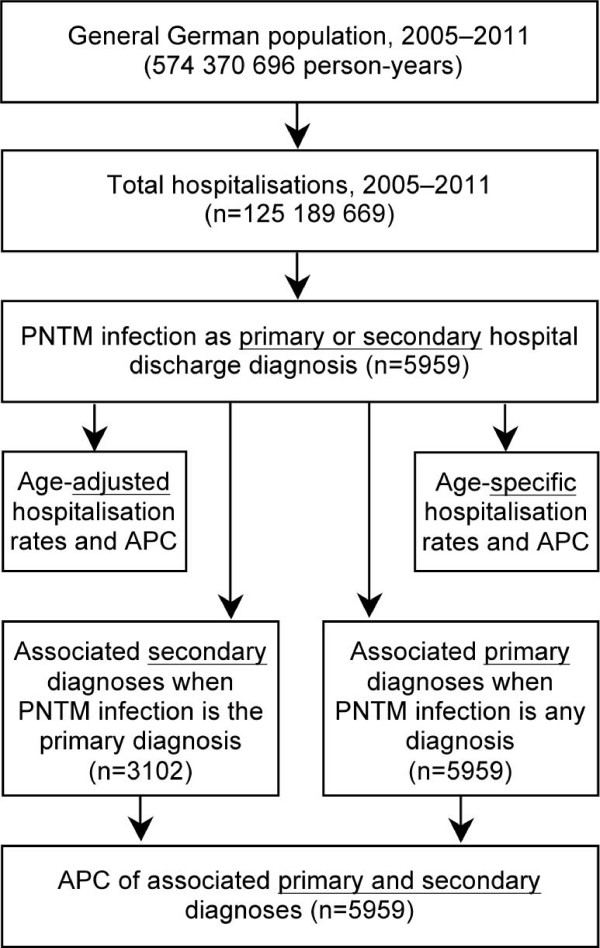
Data flow and data analysis diagram. APC = annual percentage change; PNTM = pulmonary non-tuberculous mycobacterial.